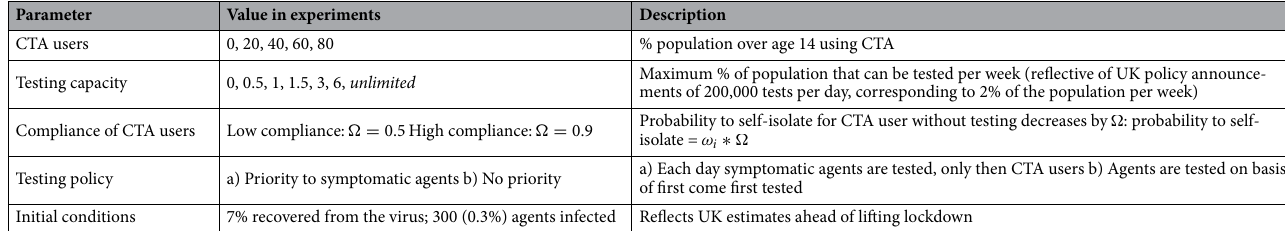
Table 2. Parameters used in simulation experiments.